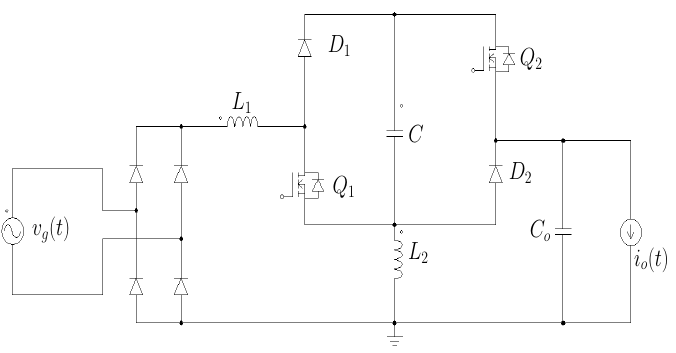
Figure 1. AC/DC single stage boost/buck power factor correction (PFC)